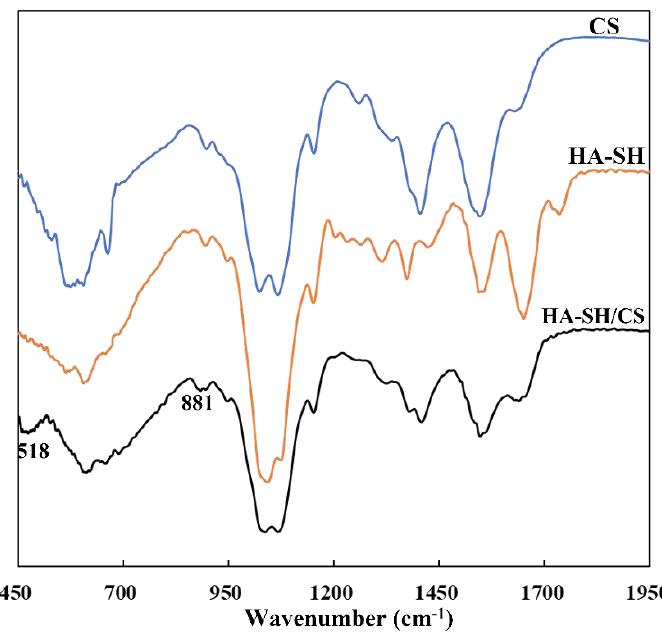
Figure 4. FT-IR spectra of CS, HA-SH, and HA-SH/CS nanoparticle (518 cm − 1 for disulfide bonds between -SH, and 881 cm − 1 for Schiff bases between CS-NH 3 + and HA-SH-COO −